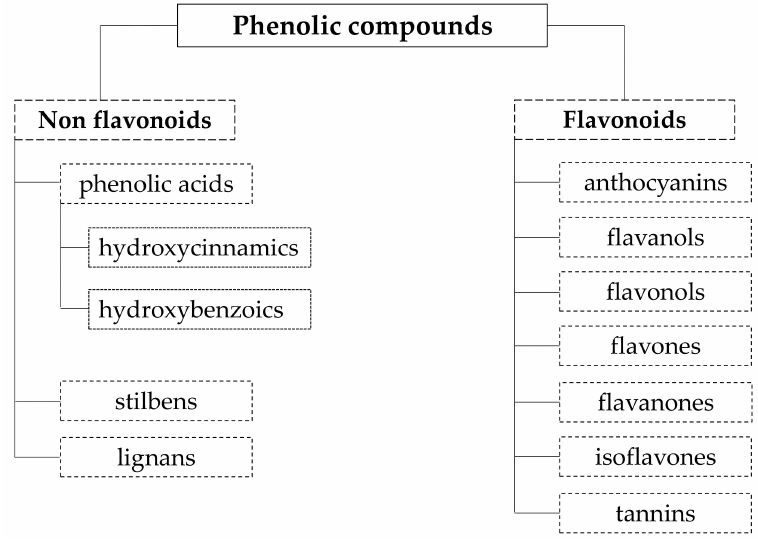
Figure 4. Polyphenol groups according to their chemical